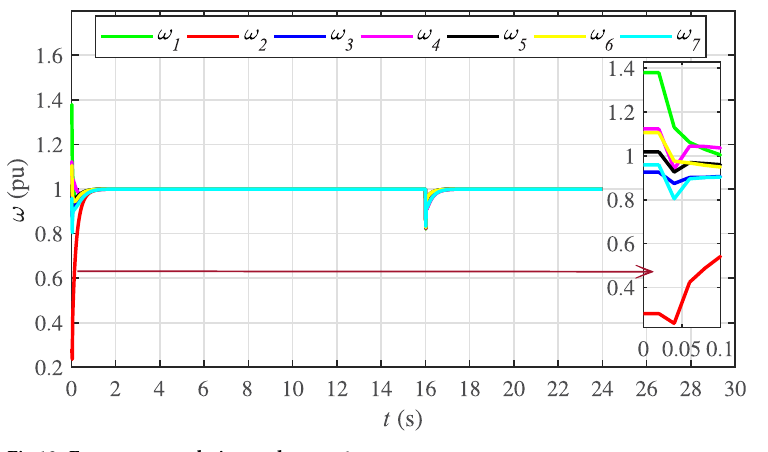
Fig 12. Frequency regulation under case 1.